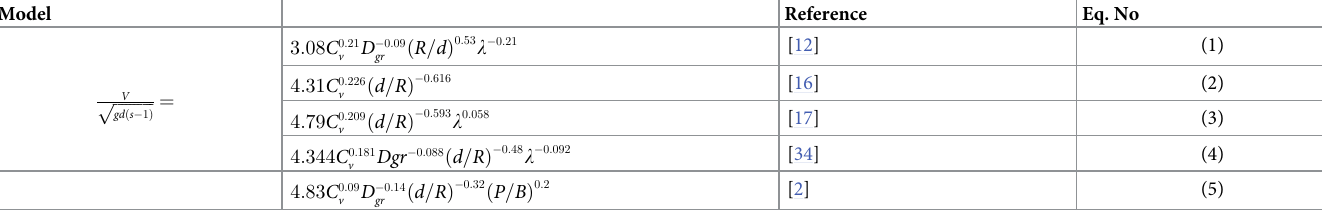
Table 1. Traditional regression equations in literature for the sediment transport self-cleansing condition.